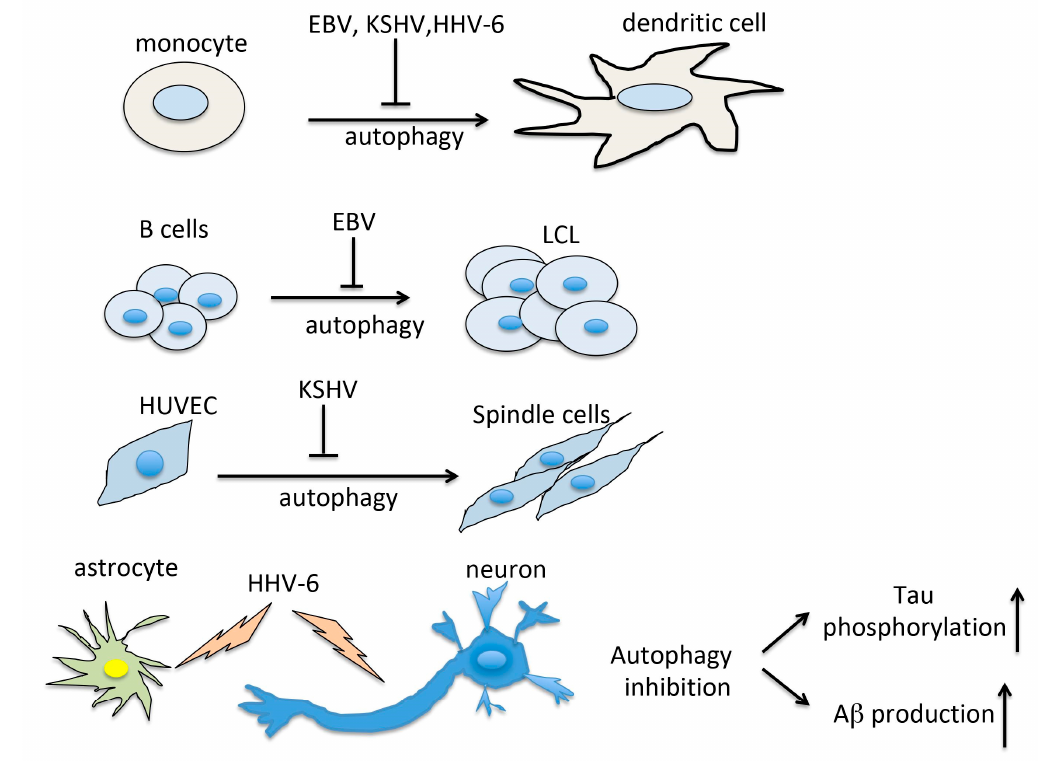
Figure 1. Scheme representing the consequence of autophagy inhibition by HHV-6, EBV and KSHV.